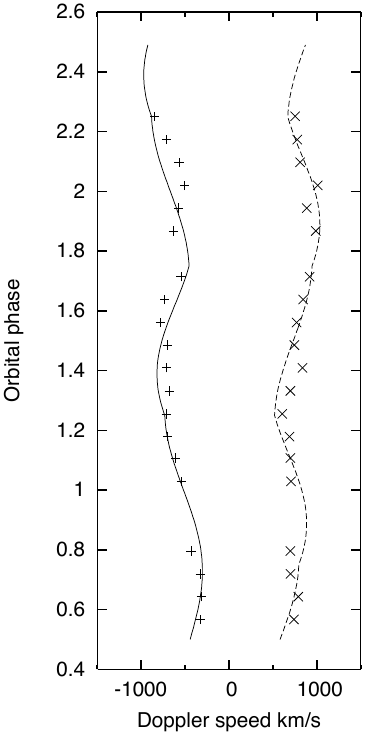
Fig.3. The upper part of the figure shows half the di ff erence between the recessional velocities of the red and blue components. This is ap- proximately the rotational velocity of the accretion disk; that part domi- nating H α emission is increasing slowly over 20 days. The lower part of the figure shows the mean recessional velocity; approximately the ve- locity of the compact object about which the accretion disk is orbiting. The oscillation is approximately sinusoidal with a period of 13 days but the extremes are delayed a little beyond phase 0.25 (compact object approaching) and 0.75 (compact object receding). The superimposed curves are from the simple model discussed in the text.